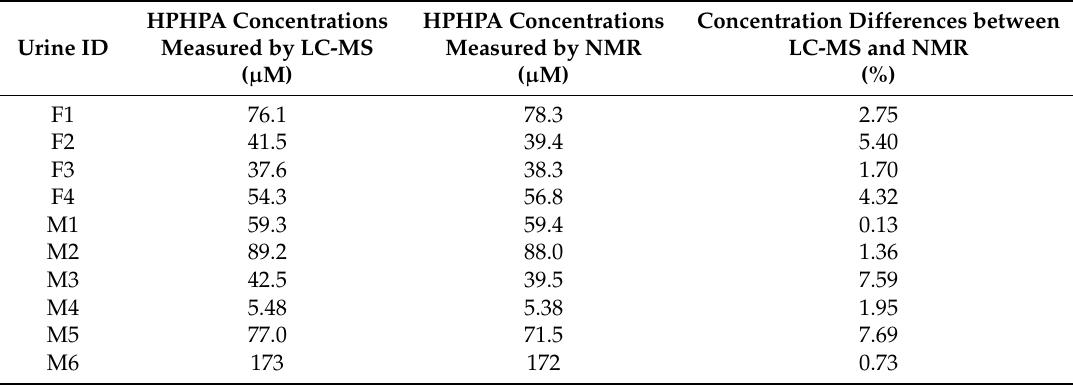
Table 1. Comparison of HPHPA concentration results measured by LC-MS and NMR.